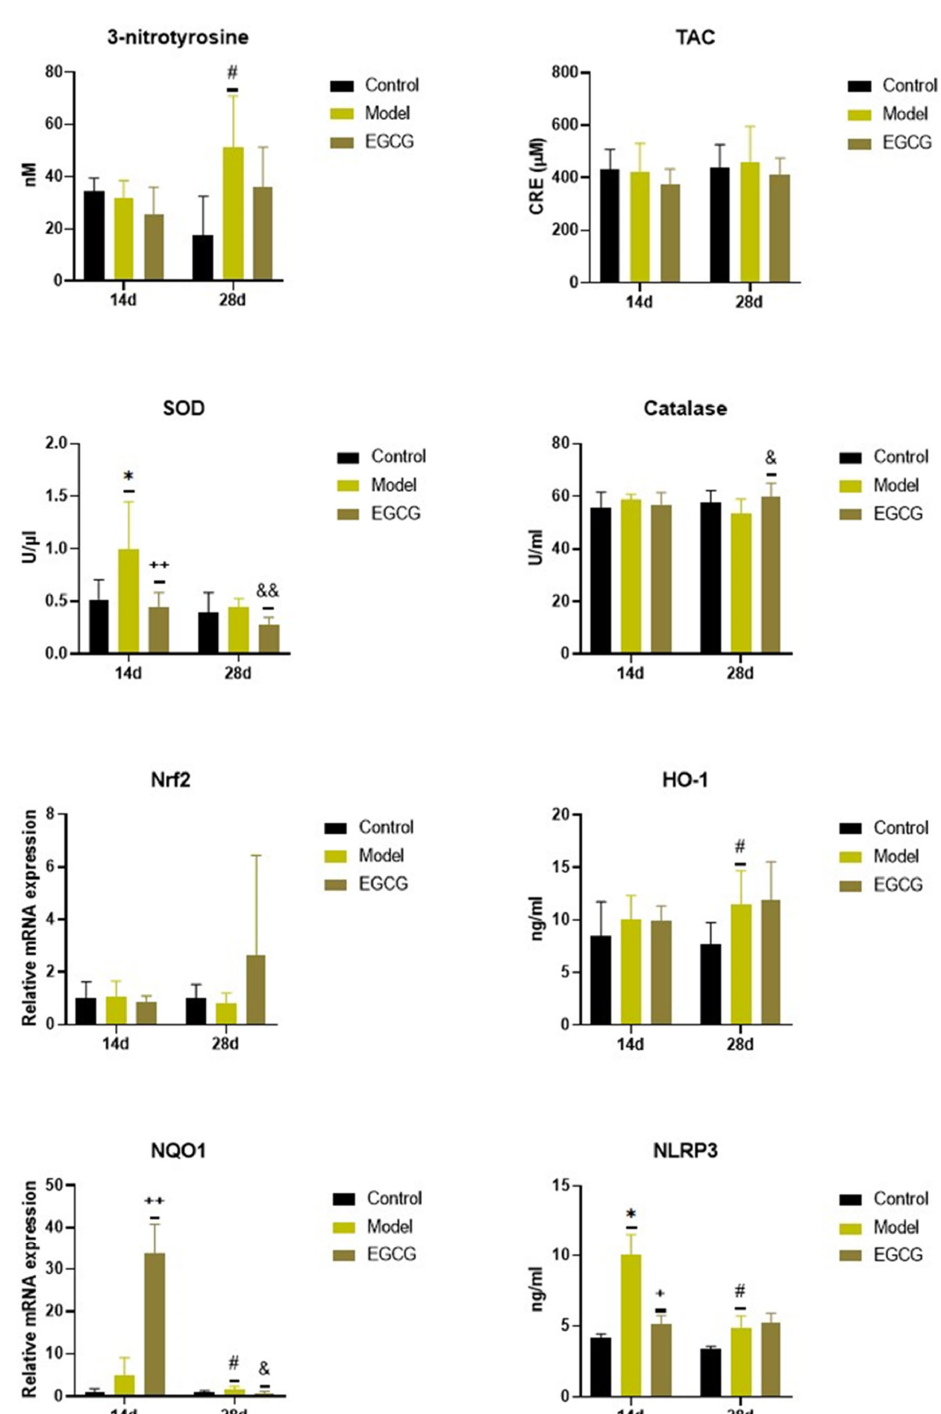
Figure 1. Changes in the oxidant/antioxidant markers in the lung of saline-instilled animals (Control), silica-instilled non-treated animals (Model), and EGCG-treated silica-instilled animals (EGCG) after 14 days (14d) or 28 days (28d) of the treatment delivery. Abbreviations: TAC: total antioxidant capacity; SOD: superoxide dismutase; Nrf2: nuclear factor erythroid-derived 2-like factor 2; HO-1: heme oxygenase; NQO-1: NAD(P)H:quinone oxidoreductase-1; NLRP3: nucleotide-binding and oligomerization domain-like receptor. For statistical differences among the groups: * p < 0.05 for Model14d vs. Control14d; + p < 0.05 and ++ p < 0.01 for EGCG14d vs. Model14d; # p < 0.05 for Model28d vs. Control28d; & p < 0.05 and && p < 0.01 for EGCG28d vs.